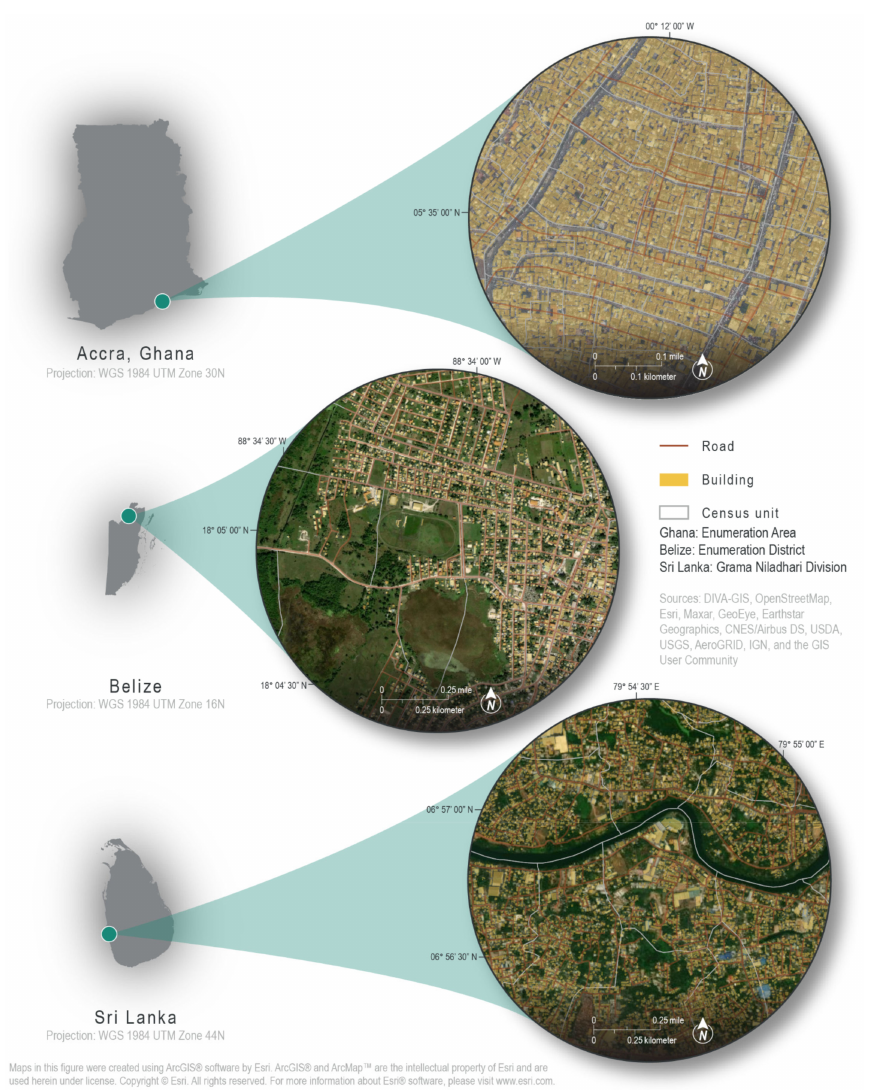
Figure 4. Example census units with complete OpenStreetMap data. All Enumeration Areas, Enu- meration Districts, and Grama Niladhari Divisions with complete and accurate road and building OpenStreetMap data were identified. Sources: [67,95,96,137]. Basemaps [137] reprinted in accordance with Terms of Use from Esri (2021). Copyright 2021